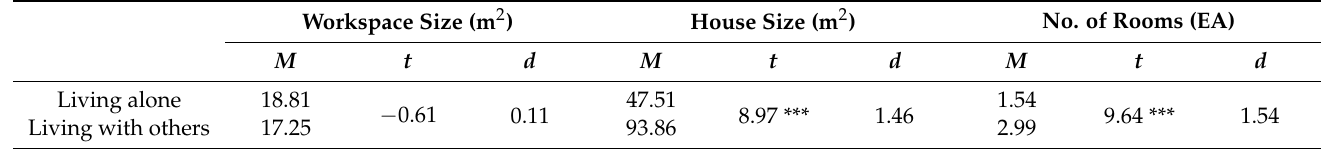
Table 4. Comparisons of those living alone and those living with others. Workspace Size (m 2 )